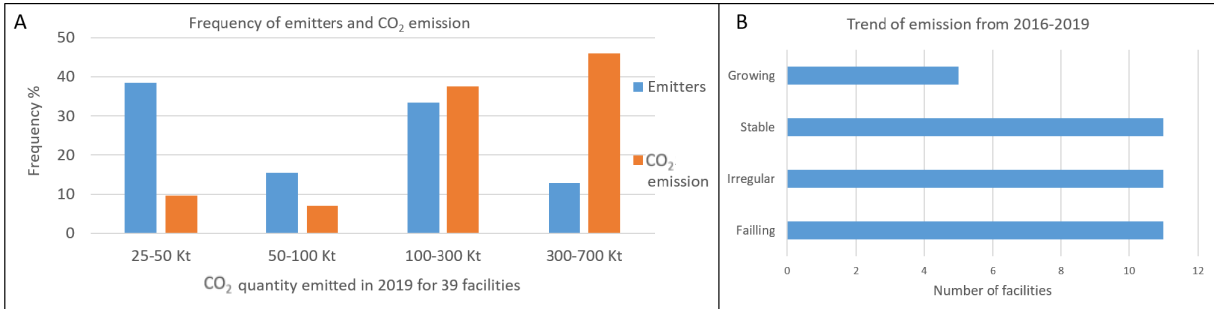
Figure 5. ( A ) CO 2 emitter facilities and CO 2 emissions frequency classed by CO 2 quantity ranges for 39 industrial facilities in the Paris Basin region. ( B ) Emission trend of these 39 facilities between 2016 and 2019. Data from [20].